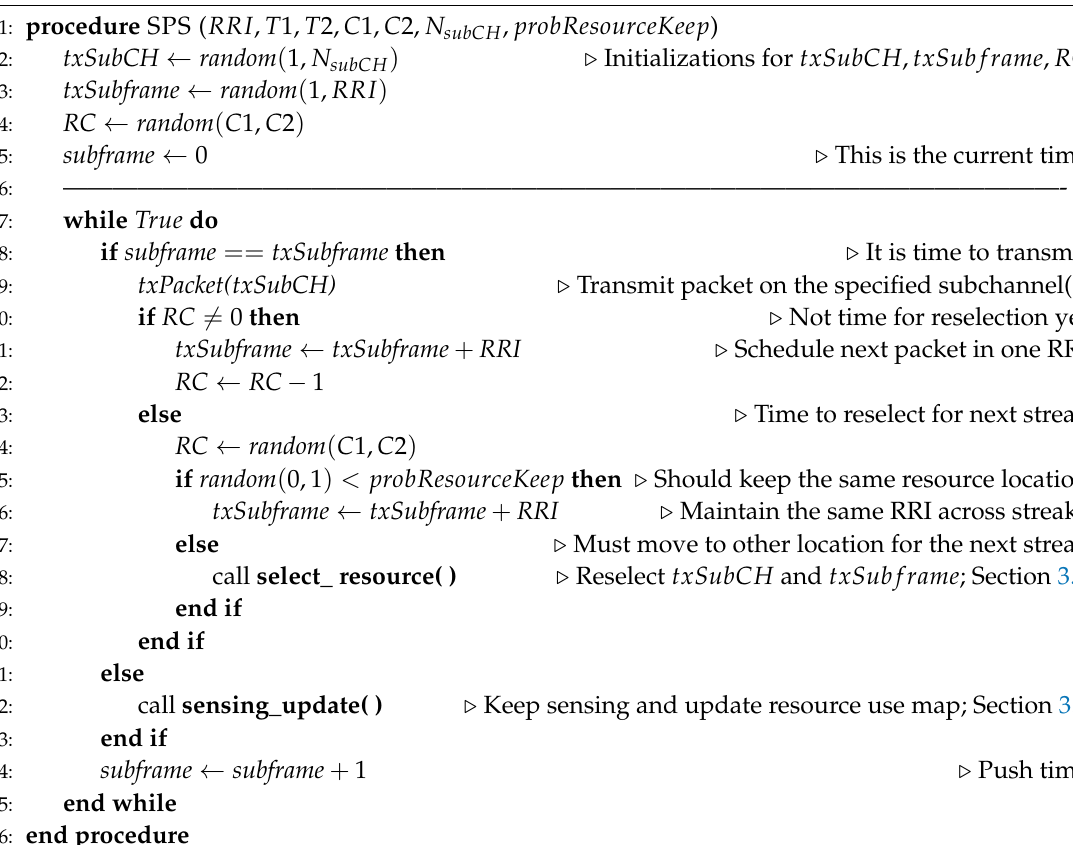
Algorithm 1 Reselection by a UE in